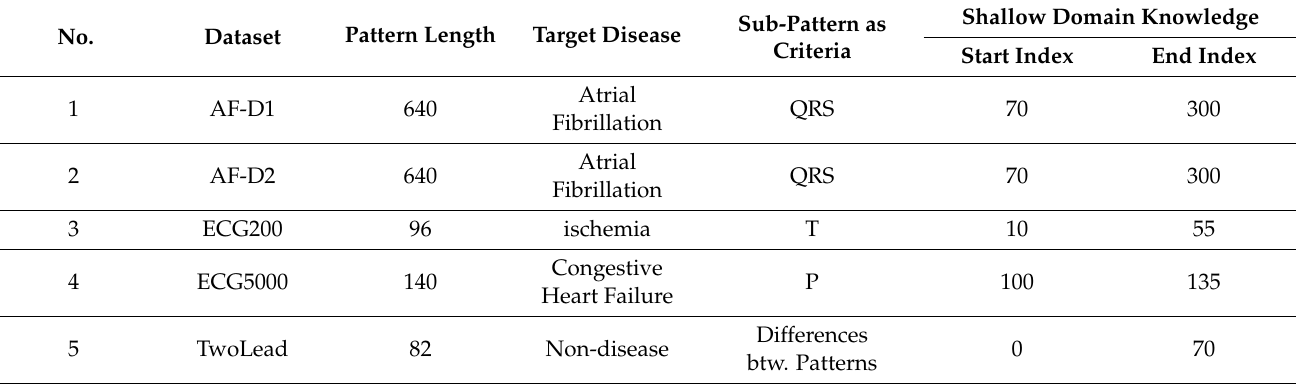
Table 7. Description of deriving optimized shallow domain knowledge for each